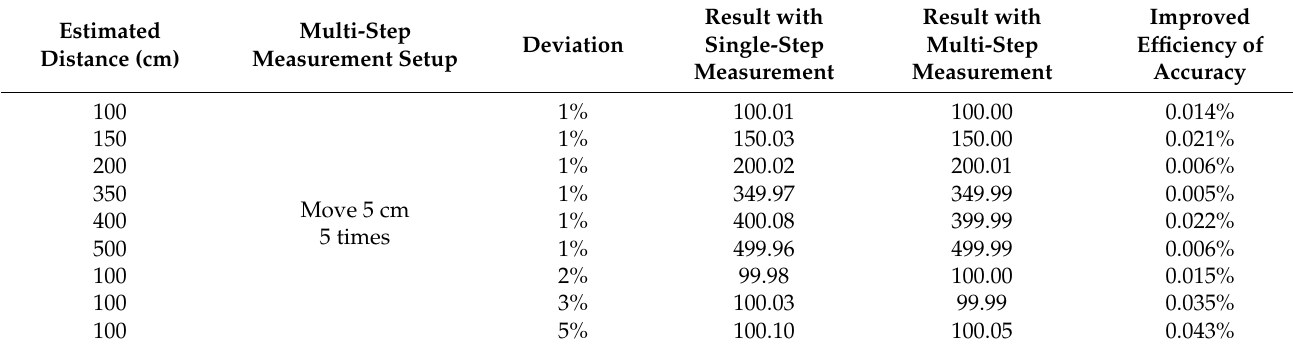
Figure 4. Simulation example when estimating distance is 100 cm. Table 3. Simulation results of multi-step measurement for deviation values of 1% to 5%.